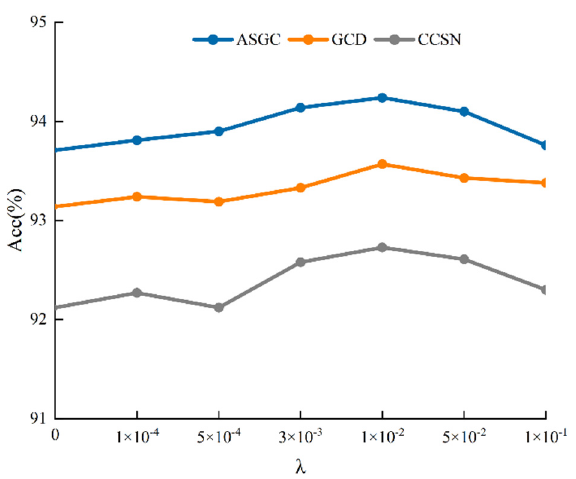
Figure 12. Analysis of the performing results of the 𝜆 parameters.